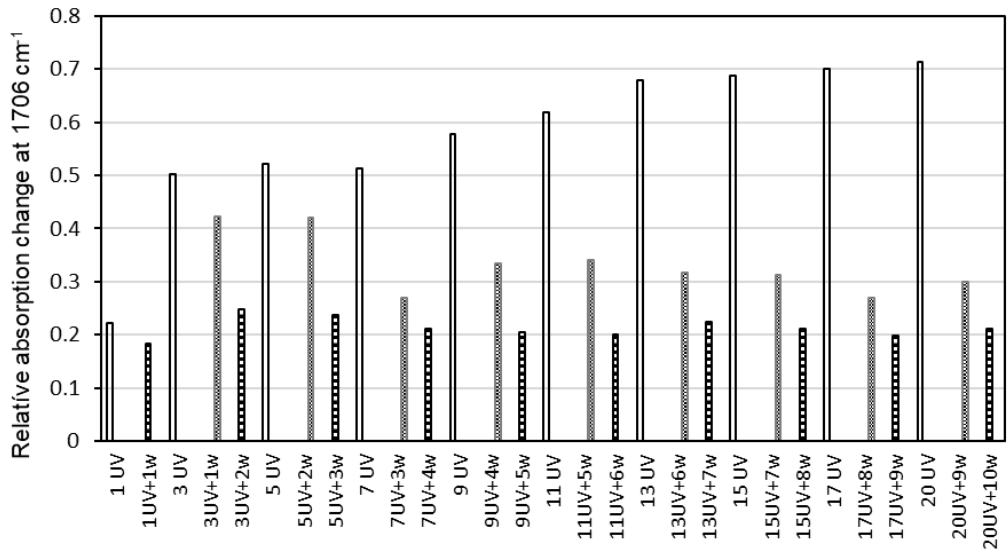
Figure 8. Absorption change of the unconjugated carbonyls at 1706 cm − 1 for Scots pine. Empty columns show the effect of pure UV irradiation. xUV = x-day UV irradiation; xUV + yw is an abbreviation where x is the extent of UV irradiation, and y is the extent of water leaching in days.